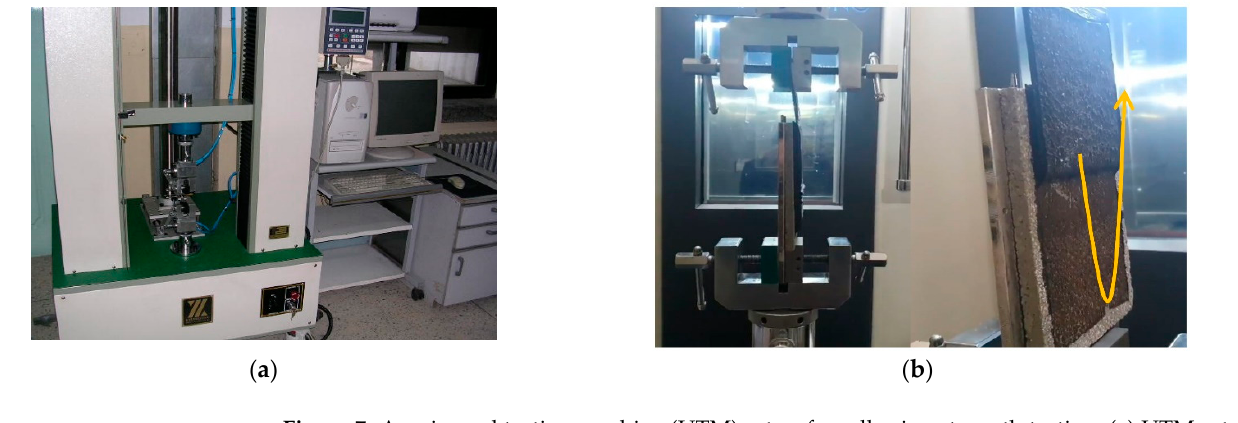
Figure 7. A universal testing machine (UTM) setup for adhesion strength testing; ( a ) UTM set up, ( b ) 180° peeling situation (refer to following sections in Figure 8 for details).